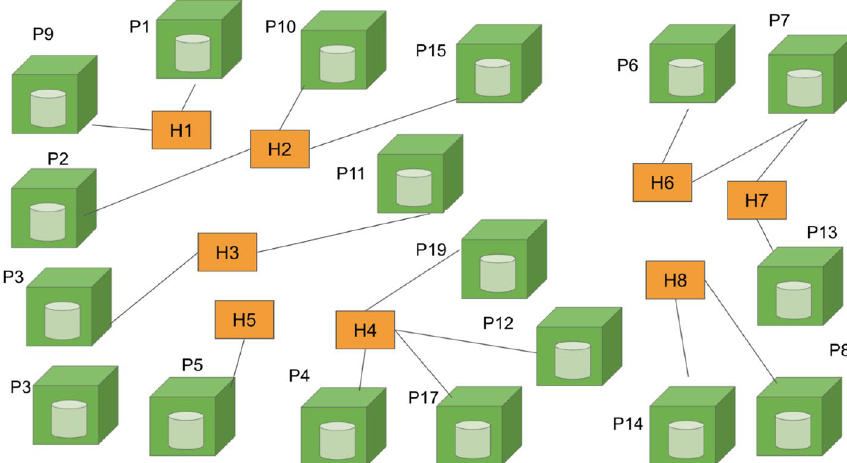
Fig. 6 Complete bipartite dengue contact graph for dengue